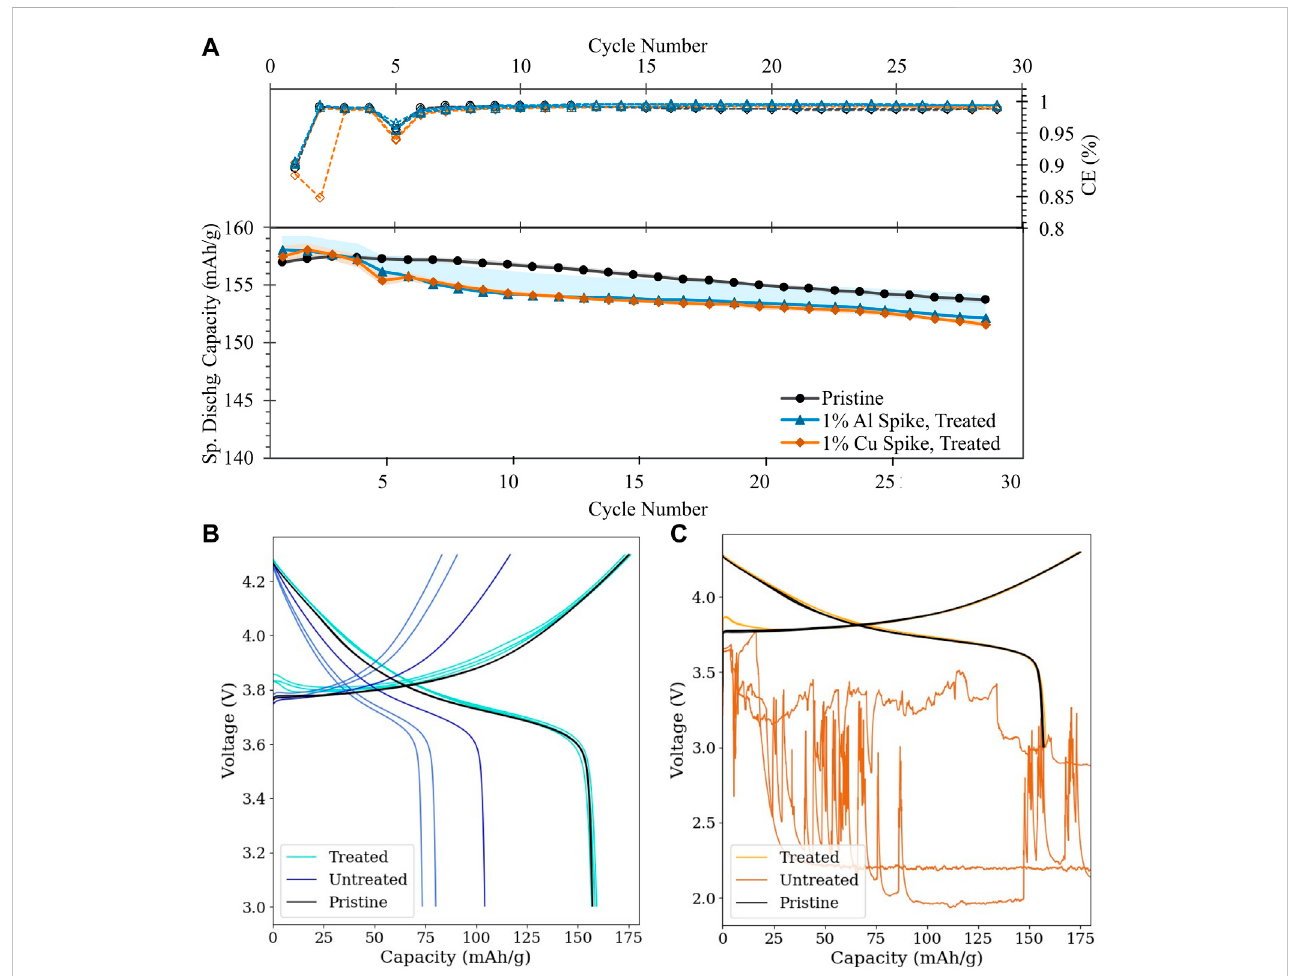
FIGURE 9 Half-cell cycling performance of simulated BM: (A) Cycling stability and Coulombic ef fi ciency of treated simulated BM (Al contamination: blue triangles; Cu contamination: orange diamonds) versus pristine NMC-111 (black circles); (B,C) First-cycle voltage pro fi les of treated vs . untreated simulated BM (B) : Al contamination; (C) Cu contamination; darker tone indicates untreated condition. Lines of the same color re fl ect cell